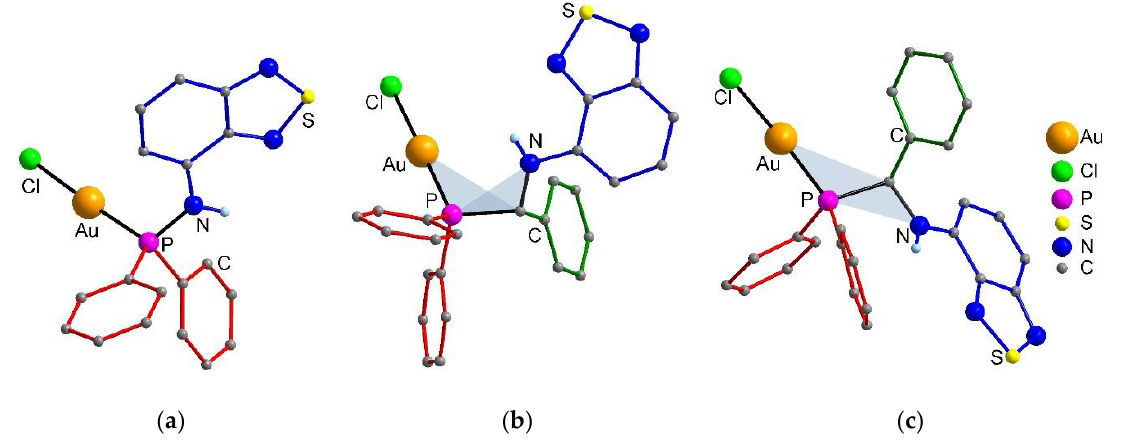
Figure 1. Crystal structures of compounds 1 ( a ), 2a , ( b ) and 2b , ( c ). Hydrogen atoms, except those belonging to the NH groups, are omitted. {Au – P – C – N} torsion angles are highlighted with transparent blue triangles.